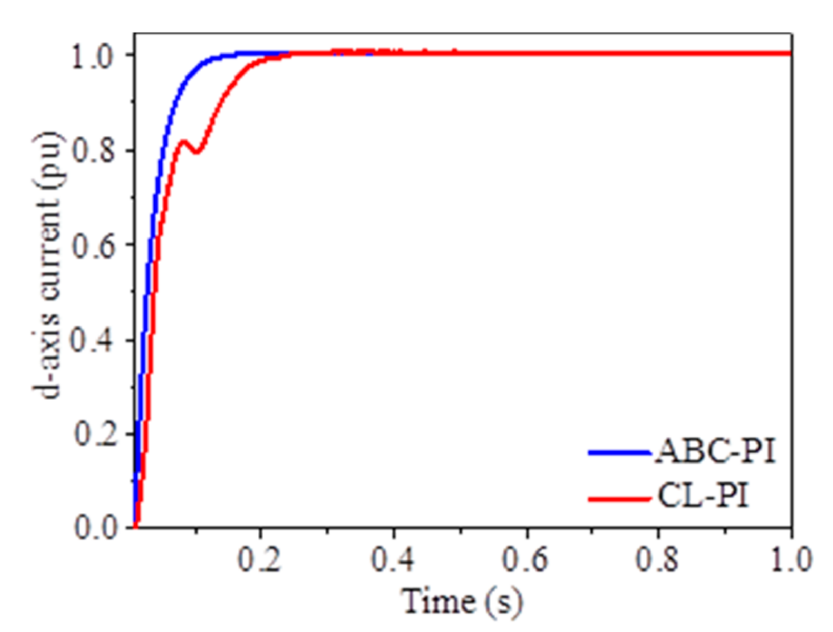
Figure 11. Step-response of the inner-current controller (ICC-L) for classical tuned PI and Artificial Bee Colony